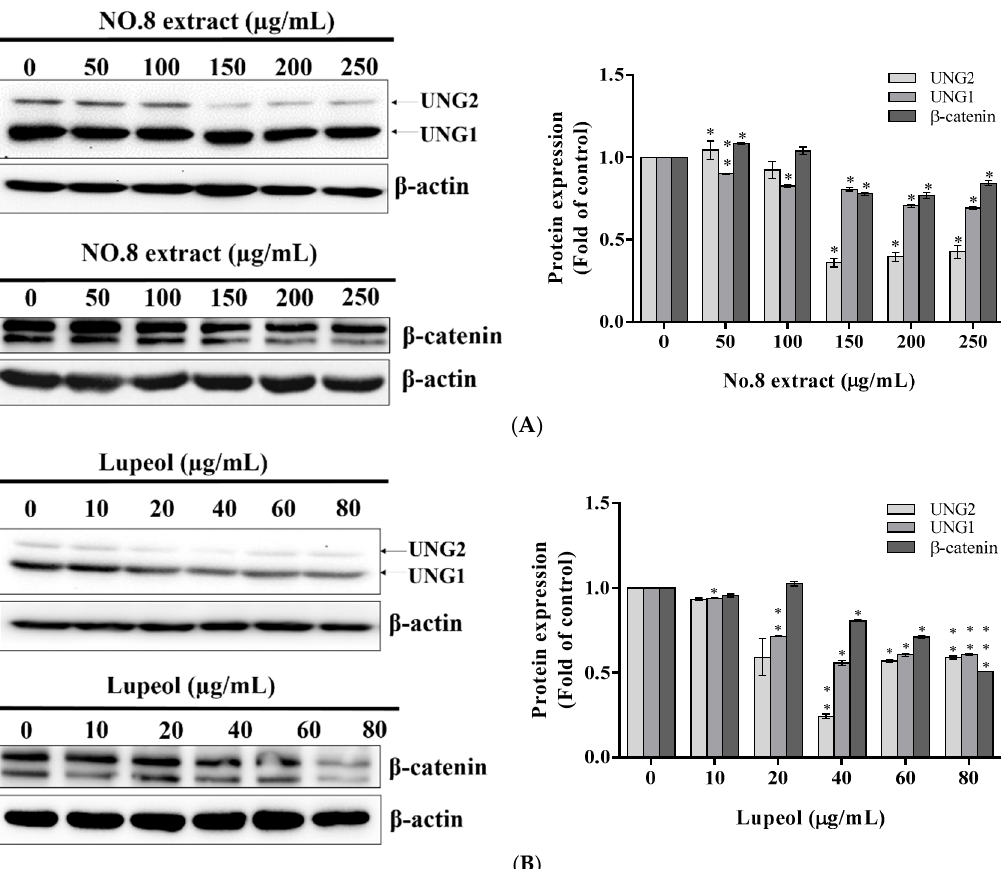
Figure 4. Lupeol and AVL ( Apocynum venetum L.) F8-inhibited expression of UNG (uracil-DNA glycosylase) and the down-regulated β -catenin signaling pathway in PC-3 cells. The UNG and β -catenin molecules were analyzed by Western blot after PC3 cells were treated by: F8 ( A ); or lupeol ( B ). β -actin was used as an internal standard. All data are expressed as the means ± standard deviation (SD) of at least three replicates ( n ≥ 3). Statistical significance was calculated by comparing with control group. * p < 0.05; ** p < 0.01; *** p < 0.001.